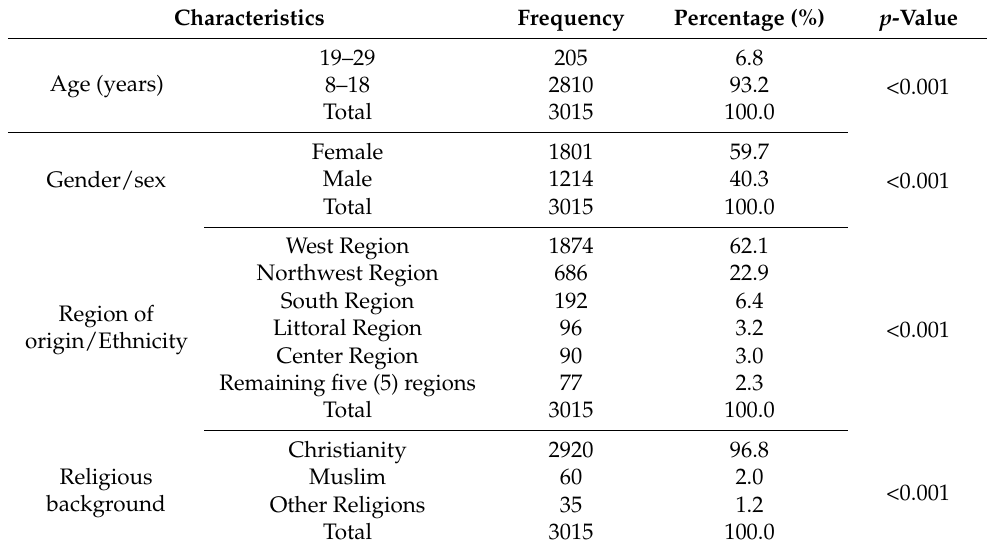
Table 1. Demographic characteristics of the